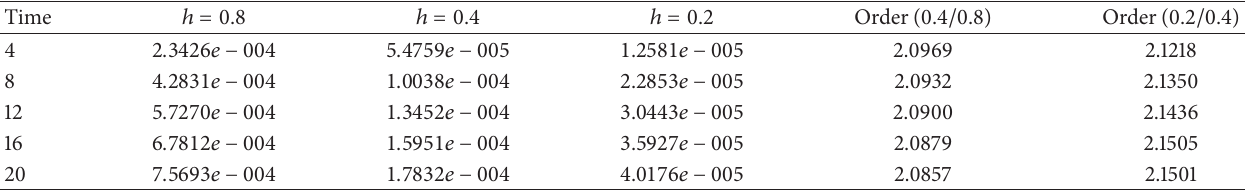
Table 8: Convergence order and error in 𝐿 2 norm for 𝑞 of space with Δ𝑡 = 0.01 and 𝑐 = 0.1